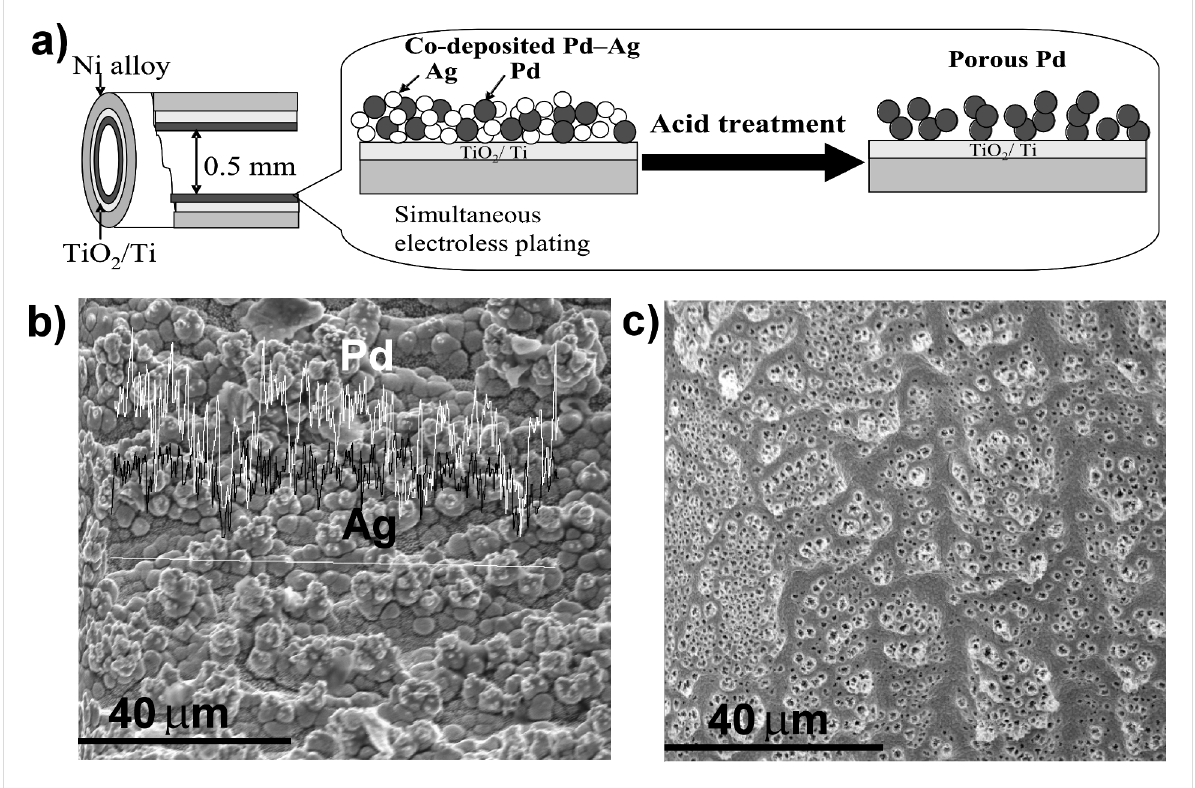
Figure 1: ( a) Graphical presentation of Pd–Ag co-plating and sequential removal of Ag to give a porous Pd surface. (b) SEM image of Pd–Ag co-plated surface along with EDX presentation of Pd and Ag deposition. (c) Surface morphology of porous Pd.